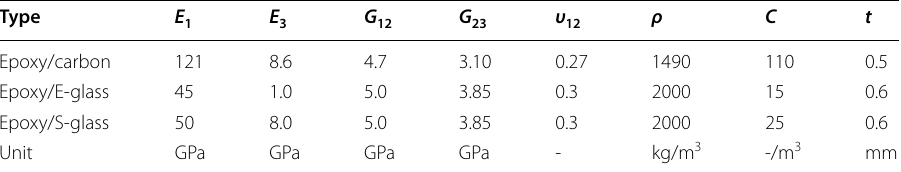
Table 1 Lamina material’s properties extracted from (ANSYS documentation)